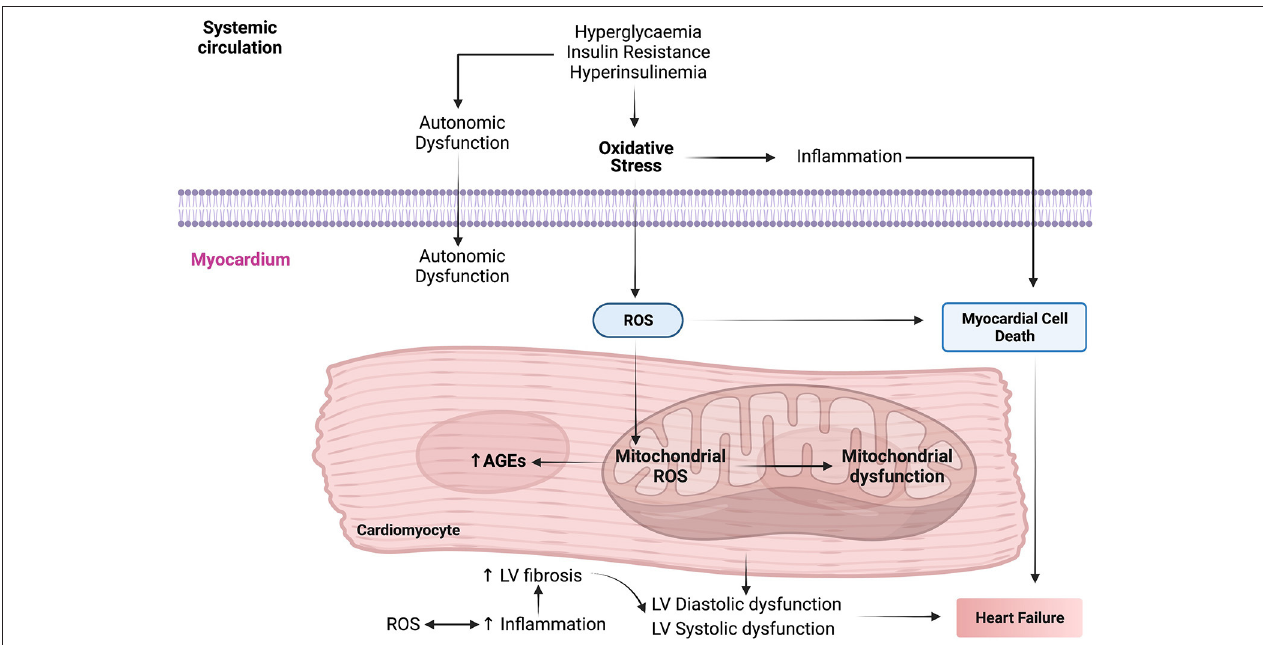
FIGURE 2 | The molecular mechanisms interactome in the pathophysiology of diabetic cardiomyopathy (DbCM). AGEs, advanced glycation end products; LV, left ventricle; ROS, reactive oxygen species.